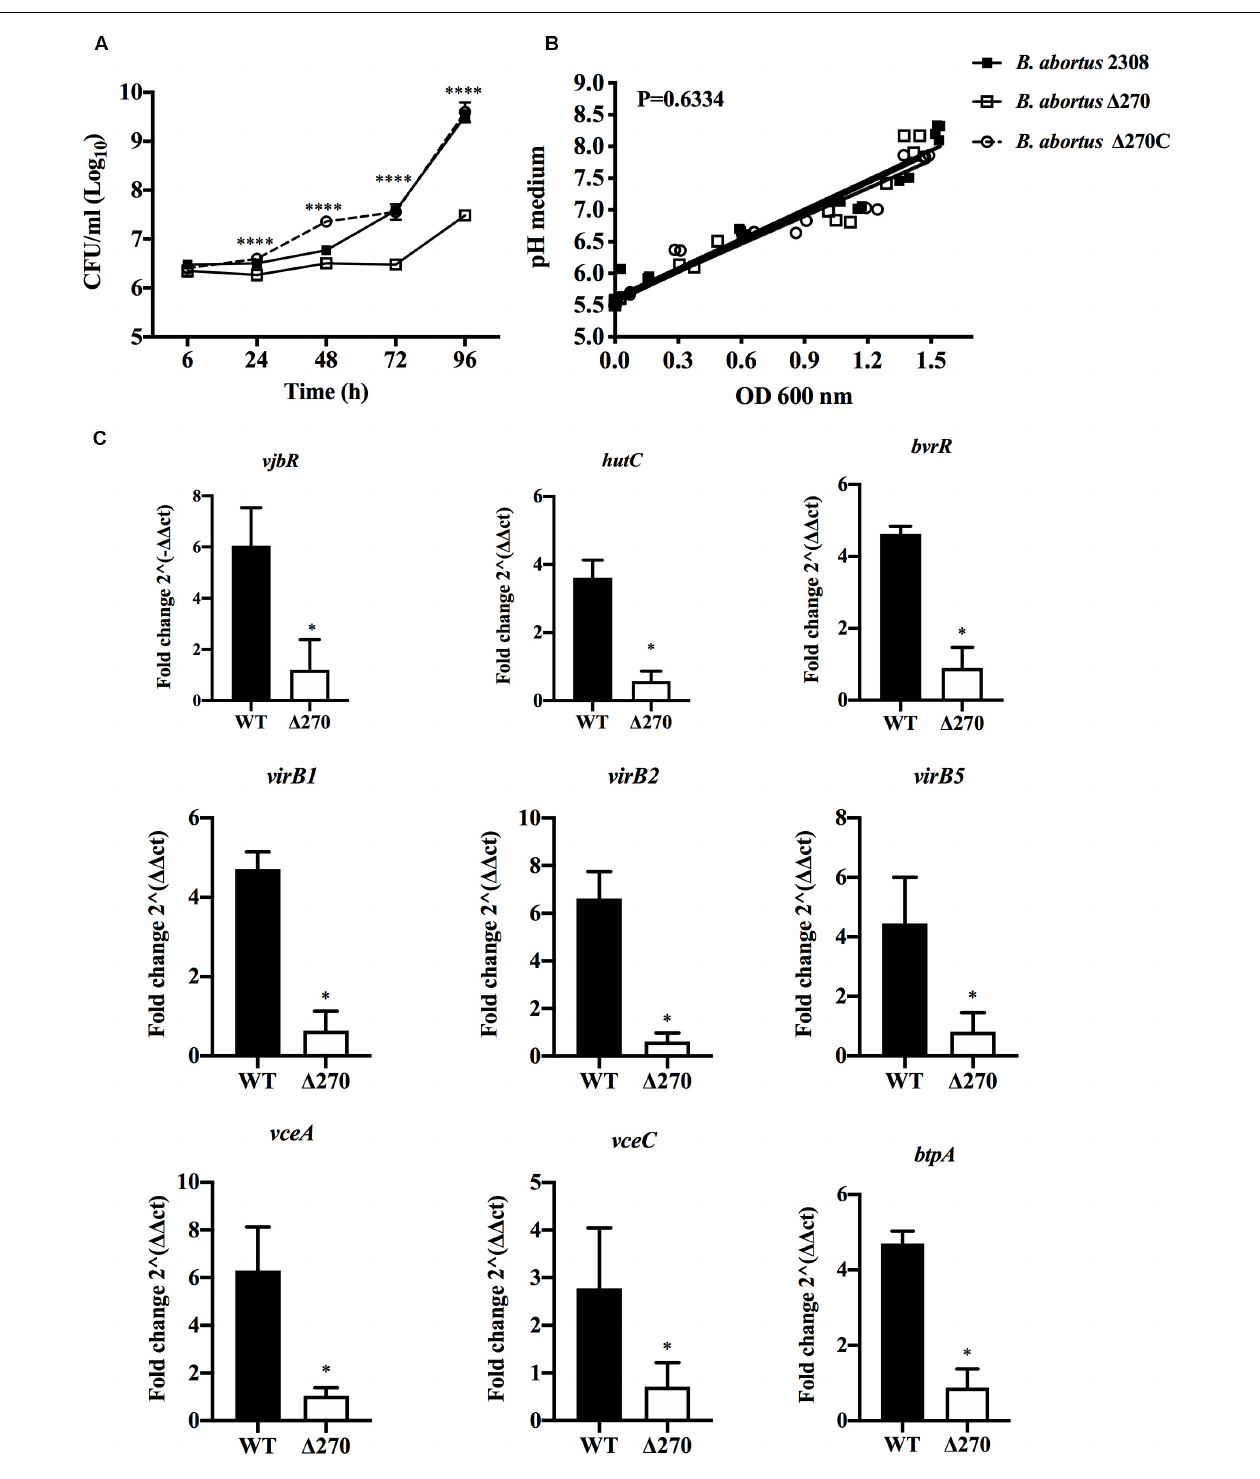
FIGURE 6 | Brucella strains growth and gene expression under acidic stress. (A) Growth curves of B. abortus 2308 , B. abortus (cid:49) 270, and B. abortus (cid:49) 270C strains cultured in acidic medium (pH 5.5). (B) Linear regression analysis of pH changes in the medium during the growth of Brucella strains. (C) The relative expression of vjbR , hutC , bvrR , virB1 , virb2 , virB5 , btpA , vceA, and vceC induced in B. abortus 2308 (wt) and B. abortus (cid:49) 270 cultured in medium with pH 5.5. The gene expression was calculated by 2 − (cid:49)(cid:49) CT method using qPCR assays at 24 h. The housekeeping genes gyrA and 16s were used as reference genes. Results were expressed as the mean ± standard deviation. P value < 0.05 were considered statistically significant, where * denotes values of P < 0.05 and **** denotes values of P < 0.0001. All assays were performed in triplicate.